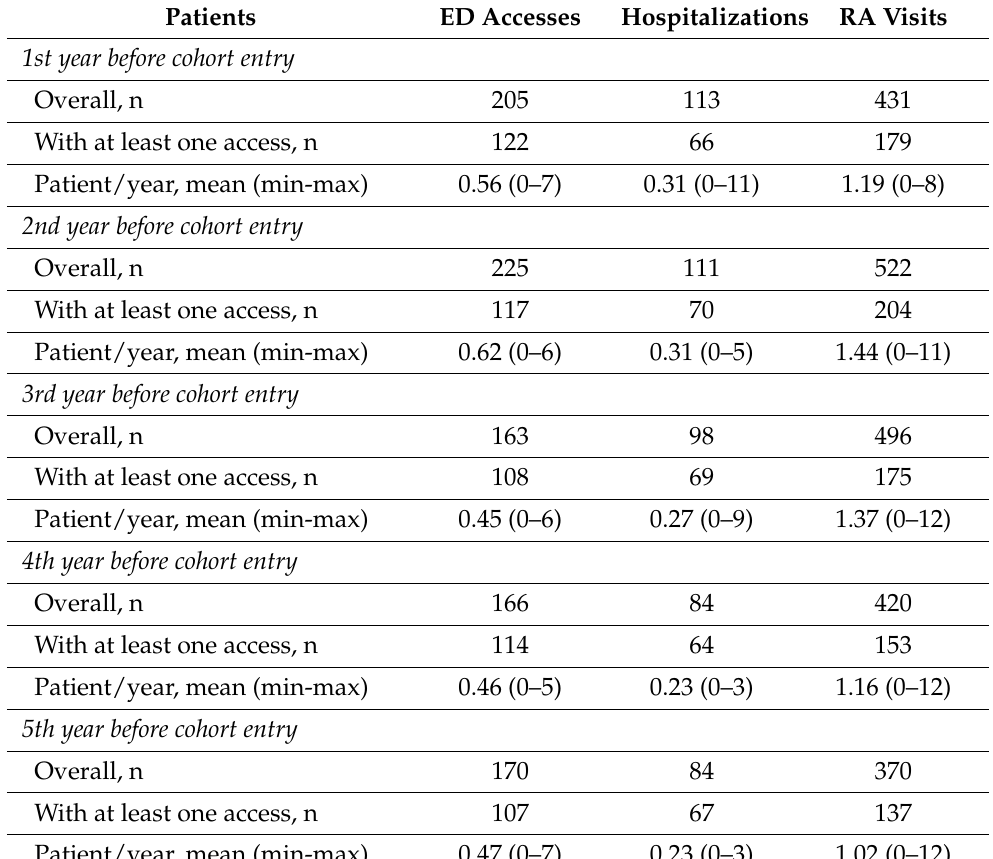
Table 3. Healthcare service facilities accessed in the years preceding the first JAKi dispensation (overall cohort, n =